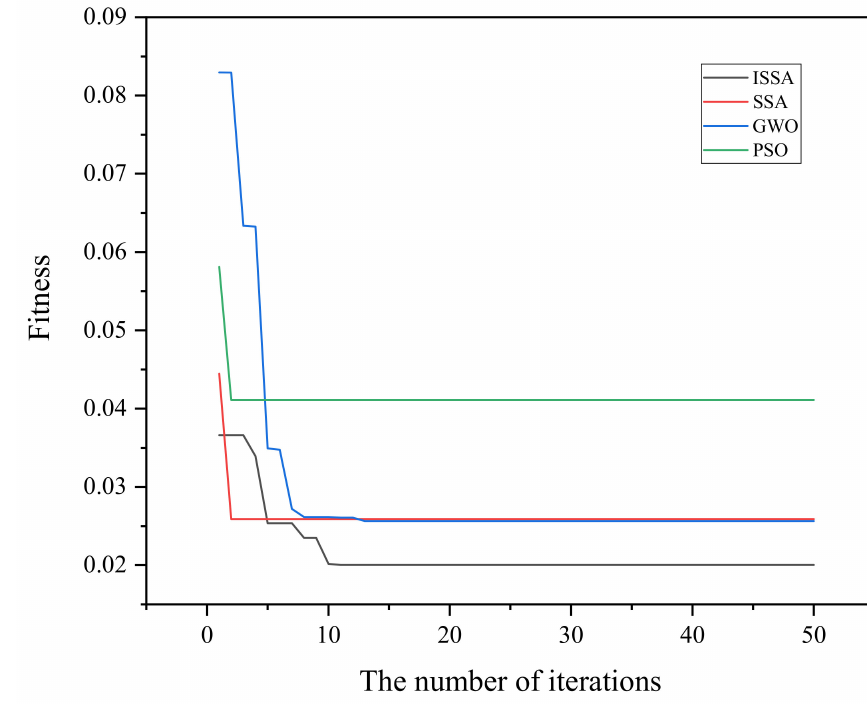
Figure 4. Iteration process of each optimization algorithm.